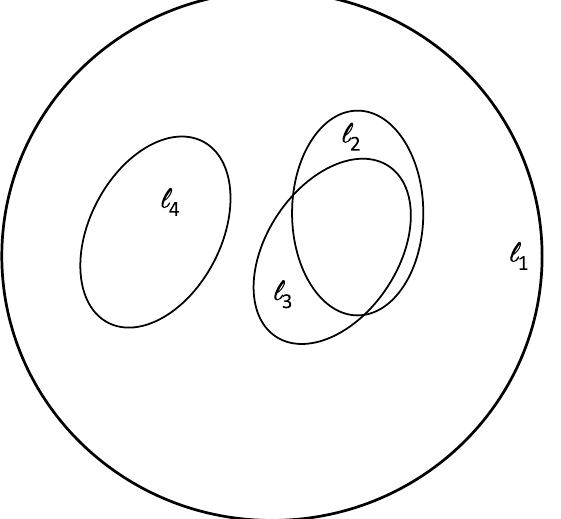
Figure 13. Schematic diagram showing the total set of critical flaw strengths (obtained at gauge length l 1 ) and possible subsets of flaw strength data obtained at various gauge lengths smaller than the critical gauge length l 1 .